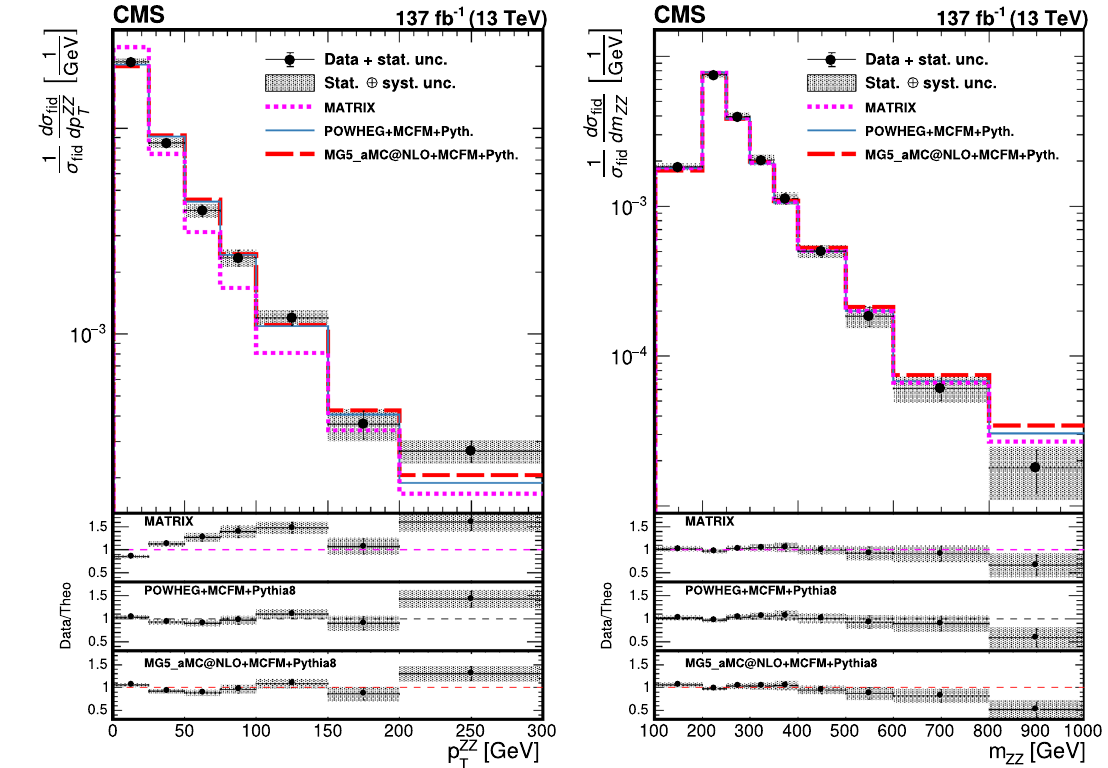
Fig. 5 Differential cross sections normalized to the fiducial cross sec- tion for the combined 4e, 2e2 μ , and 4 μ decay channels as a function of (left) p T of the ZZ system, (right) the invariant mass of the ZZ system. The points represent the unfolded data with error bars show- ing the statistical uncertainties, shaded histogram the powheg + mcfm ZZ predictions, and the dashed curves correspond to the results of the Matrix and MadGraph 5_a mc@nlo + mcfm calculations. The